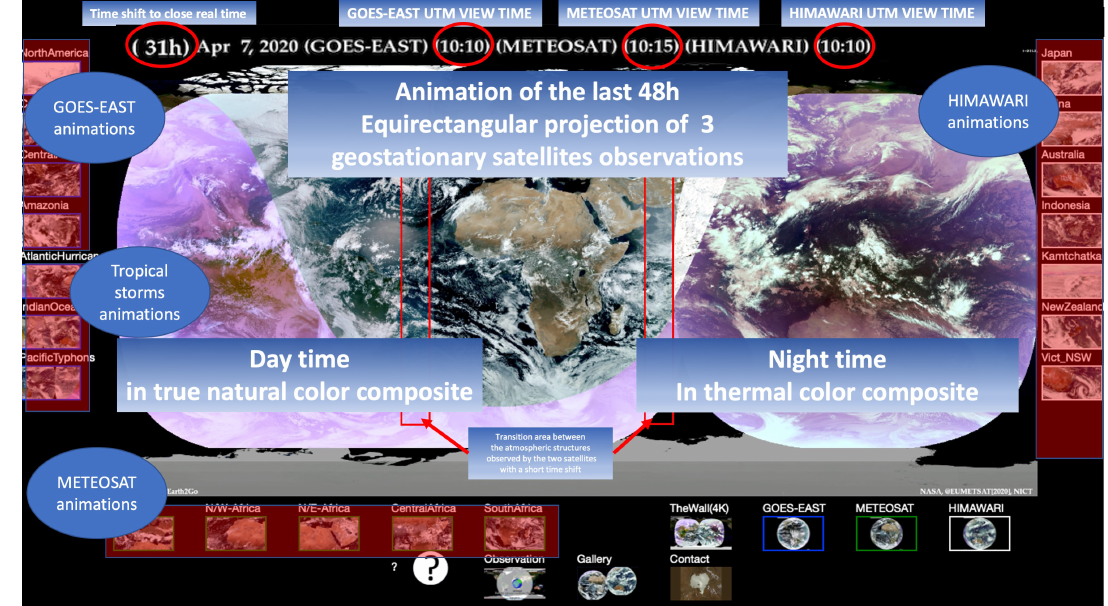
Figure 14. “The Wall” flowchart. “The Wall” system is divided in three levels. The first level is devoted to the data acquisition from the three geostationary satellites (EUMETCAST distribution, Google Cloud Platform, and the NICT Science Cloud [10,11]). The second level computes the RGB true natural color composites. The third one creates all the animated global mosaics and subsets.